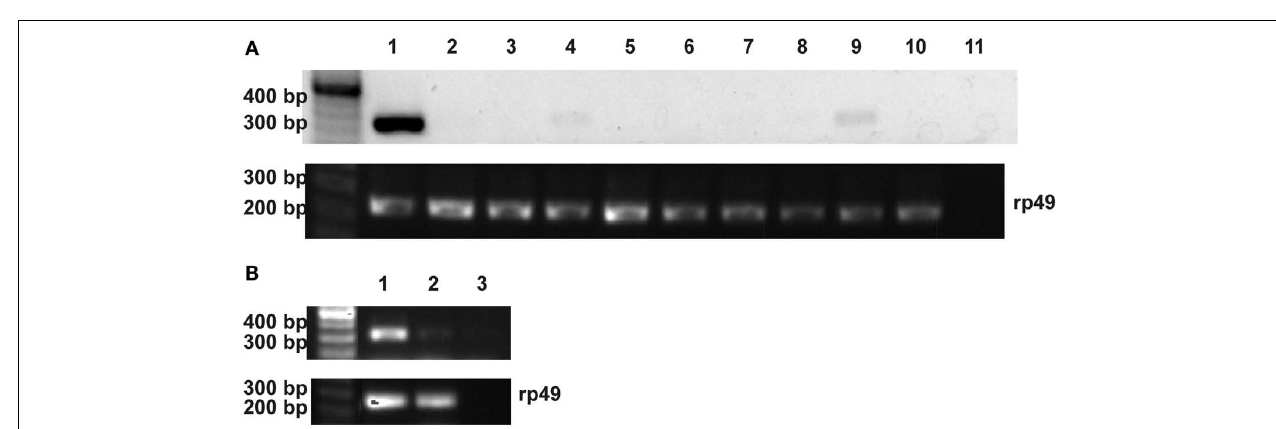
FIGURE 2 |Alignment of known proctolin prepropeptides. Sequences from R. prolixus , A. pisum , (ACYPIG674496), T . castaneum (EFA05689.1), D . melanogaster (NP609158.2), L. vannamei (FE183480), and D. pulex